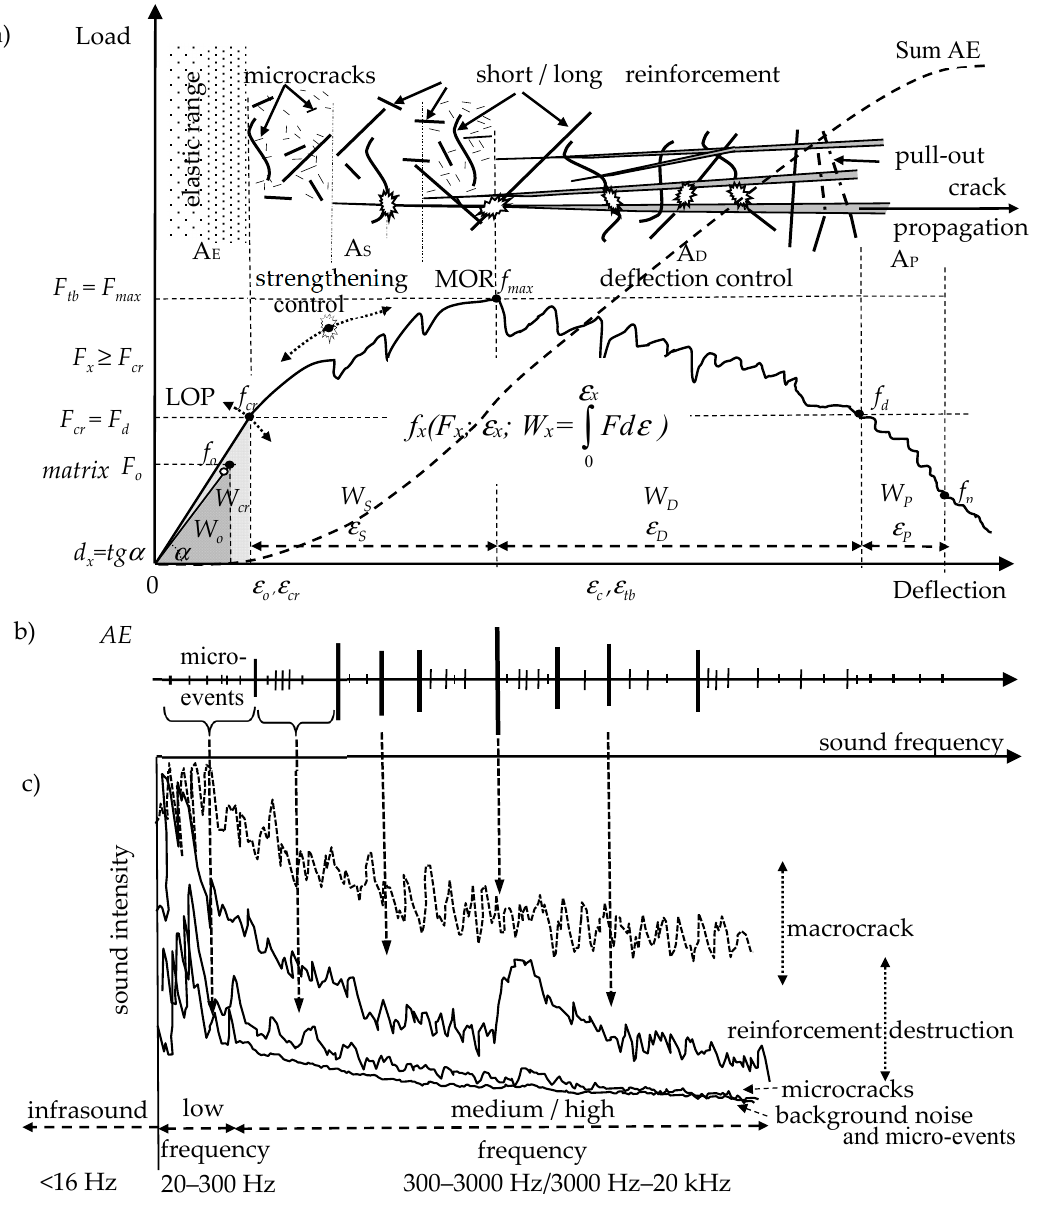
Figure 2. The quasi-brittle composite: ( a ) load-deflection curve, ( b ) AE, acoustic emission effects, ( c ) 2D acoustic spectrum (frequency amplitude depending on sound intensity) based on [36].